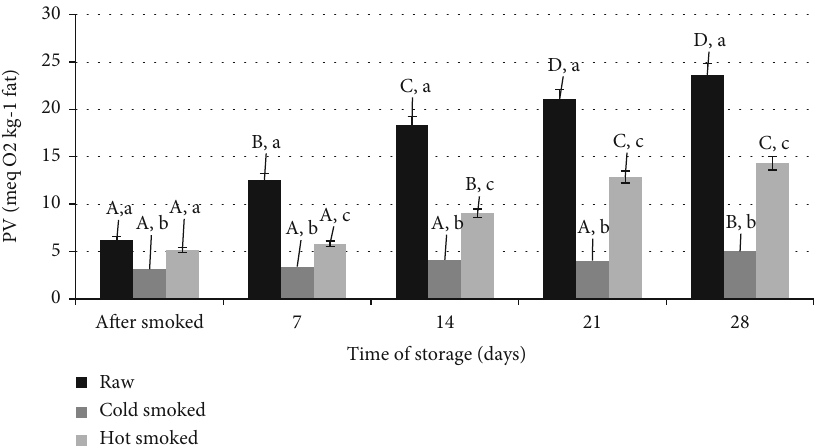
Figure 2: Comparison of changes in the peroxide number during storage of raw, cold- and hot-smoked salmon. a, b, c: signi fi cant di ff erences ( n = 3 ) between individual treatments within one storage time. A, B, C, D: signi fi cant di ff erences ( n = 3 ) between treatments during storage.